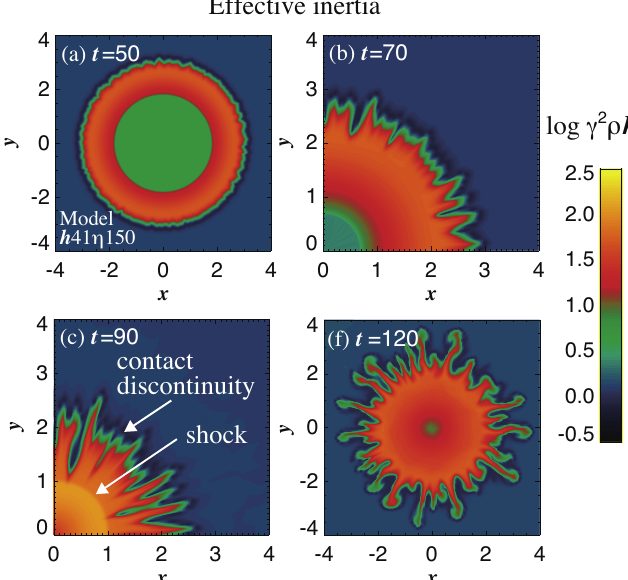
Figure 2. The image shows panels of the logarithm of the effective inertia ( γ 2 ρ h in units of ambient rest-mass energy density, ρ a c 2 ) along an expanding and recollimating jet from the simulations in [80]. The development of the RTI can be clearly observed (adapted from [80], courtesy of Jin